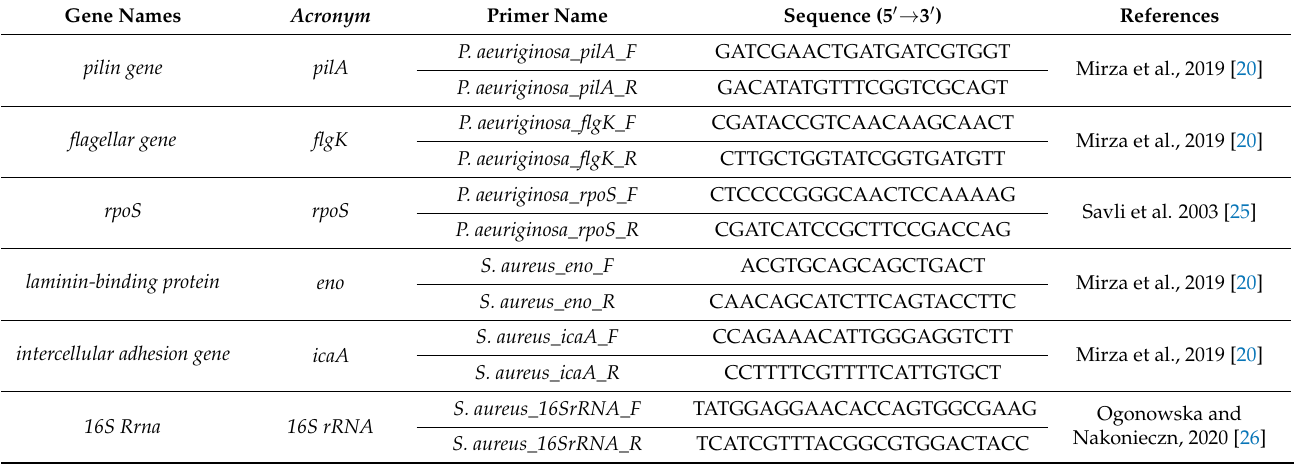
Table 1. Gene names, acronym, primer name, sequence, and references of primers.